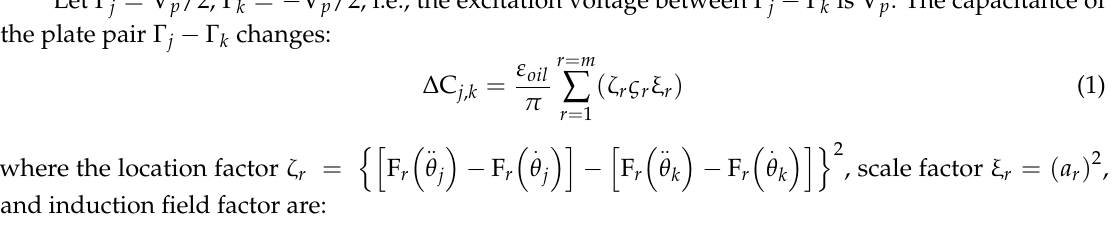
Figure 2. Detection of multi-wear debris capacitance array.